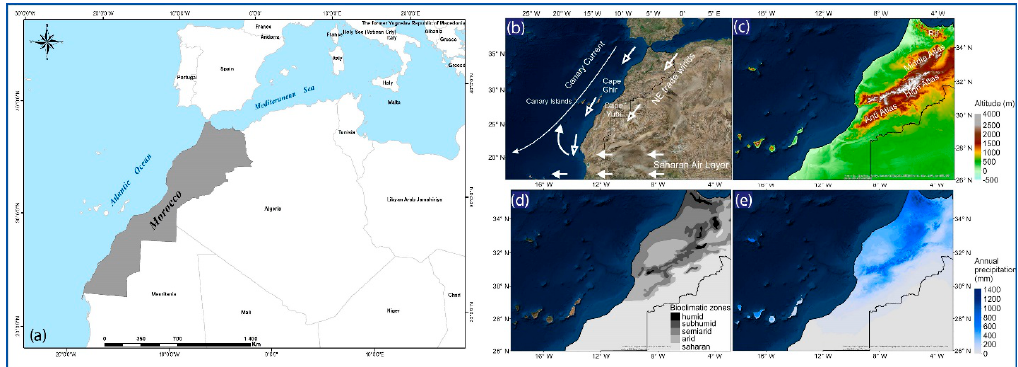
Figure 1. ( a ) Geographic location of Morocco, ( b ) main atmospheric systems (NE trade winds and Saharan air layer) and the Canary Current, ( c ) regional topography including the Rif, Middle Atlas, High Atlas and Anti Atlas mountain ranges, ( d ) bioclimatic zones and ( e ) annual precipitation ( b – e were adapted from [16]).